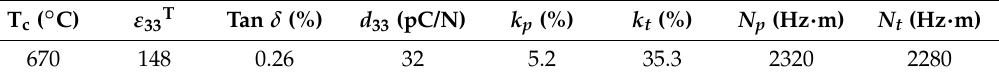
Table 1. Electrical properties of Co-doped Na 0.5 Bi 4.5 Ti 4 O 15 (NBT-Co) ceramics.